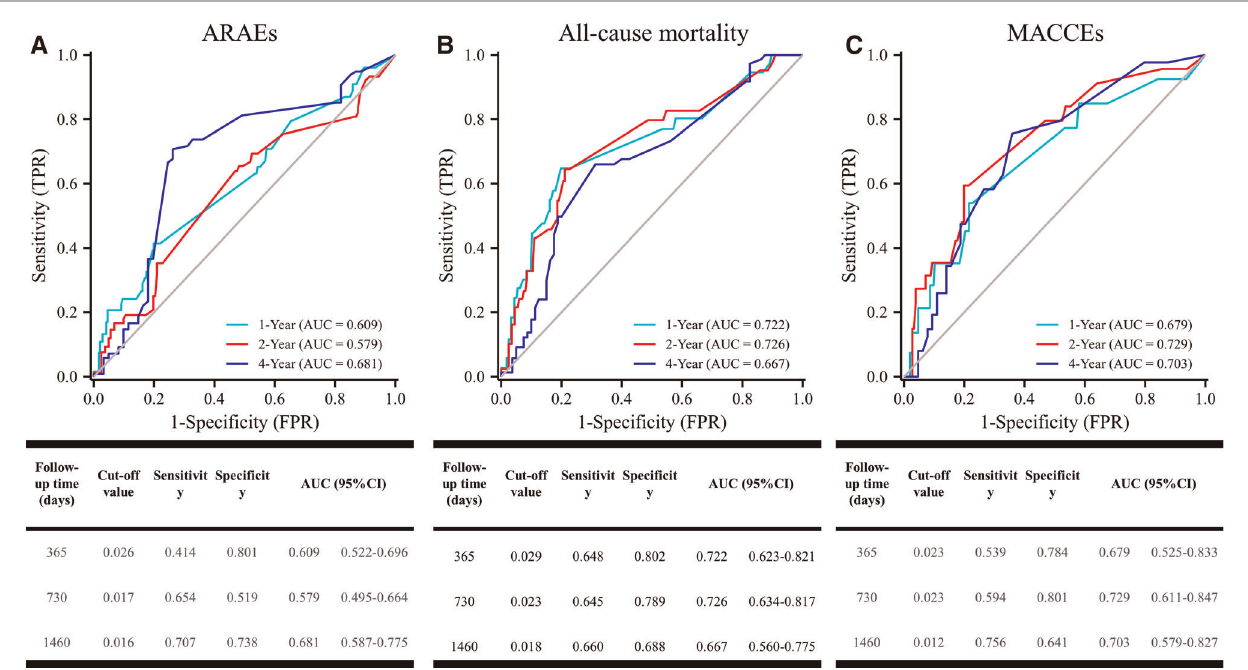
FIGURE 3 | Time-dependent ROC curve analysis for cTnI predicting all-cause mortality. ROC, receiver operating characteristic.